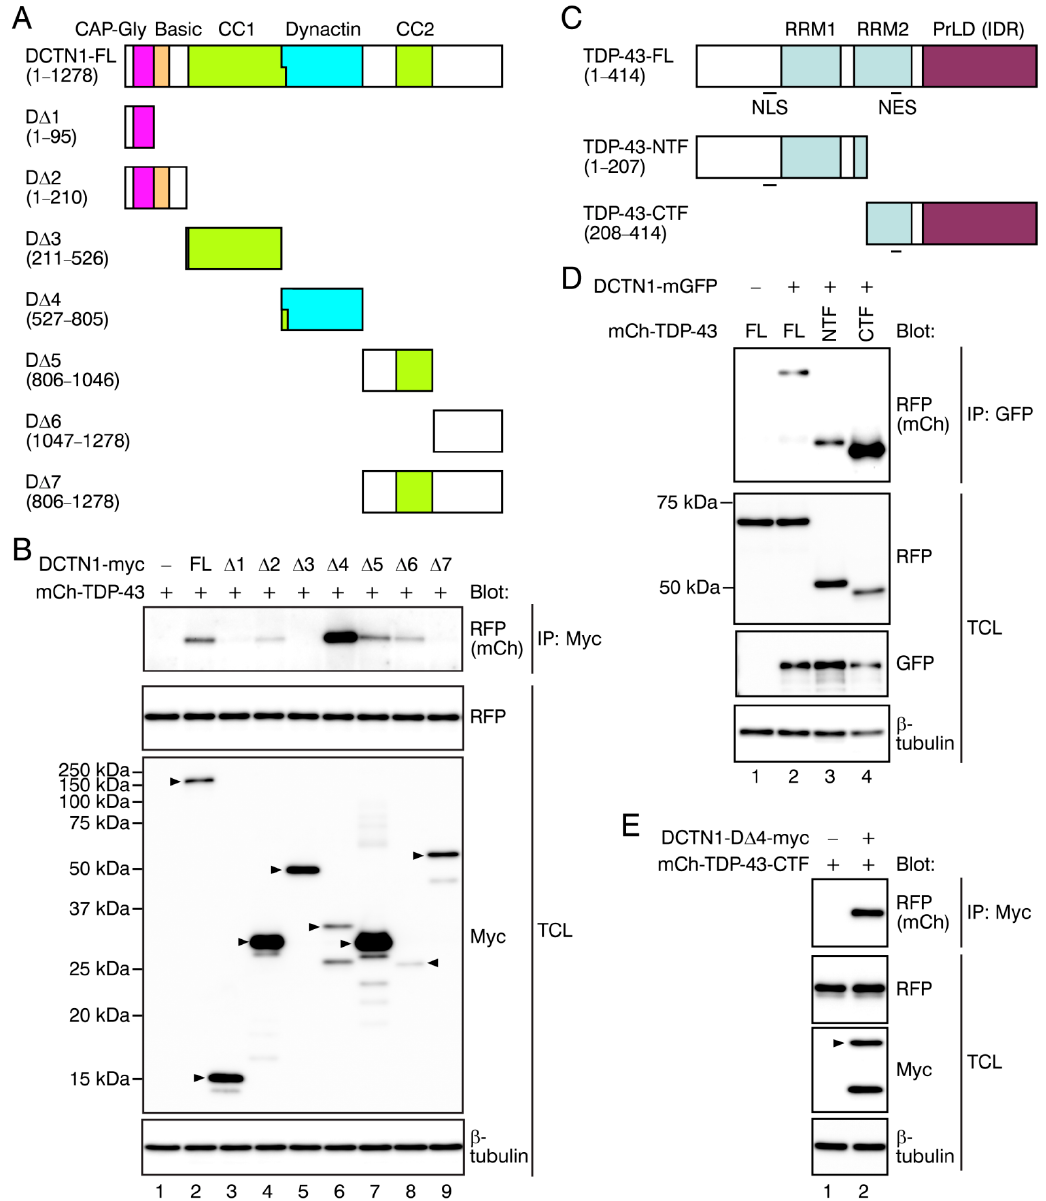
Figure 2. The interacting regions of DCTN1 and TDP-43. ( A ) Schematic representations of a series of truncated forms of mutant DCTN1 used in this study. FL: full-length. ( B ) Coimmunoprecipitation (co-IP) of DCTN1-myc mutants with mCherry-FL TDP-43 in COS-7 cells. Immunoprecipitation and Western blotting were performed using the antibodies indicated. Arrowheads in the Western blots indicate the expected positions of tagged DCTN1 fragments. ( C ) Schematic representations of the N-terminal fragment (NTF) and C-terminal fragment (CTF) of TDP-43. ( D ) Coimmunoprecipitation between FL DCTN1-mGFP and mCherry-TDP-43-NTF or CTF. ( E ) Coimmunoprecipitation between myc-tagged DCTN1 D ∆ 4 fragment and mCherry-tagged TDP-43-CTF.